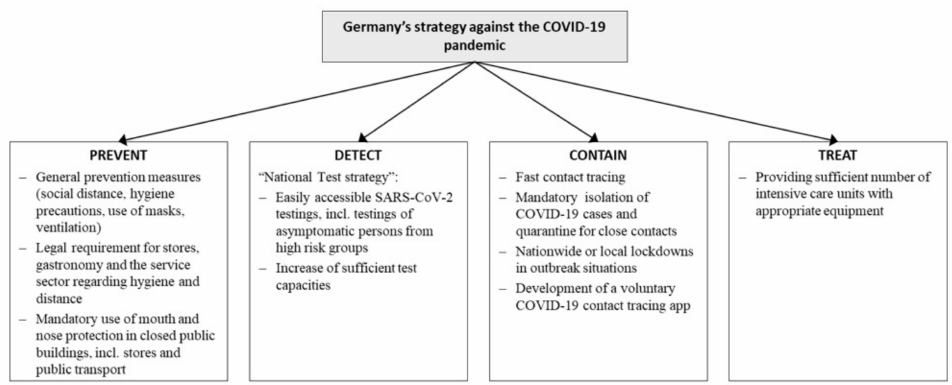
Figure 1. Germany’s technical strategy against the COVID-19